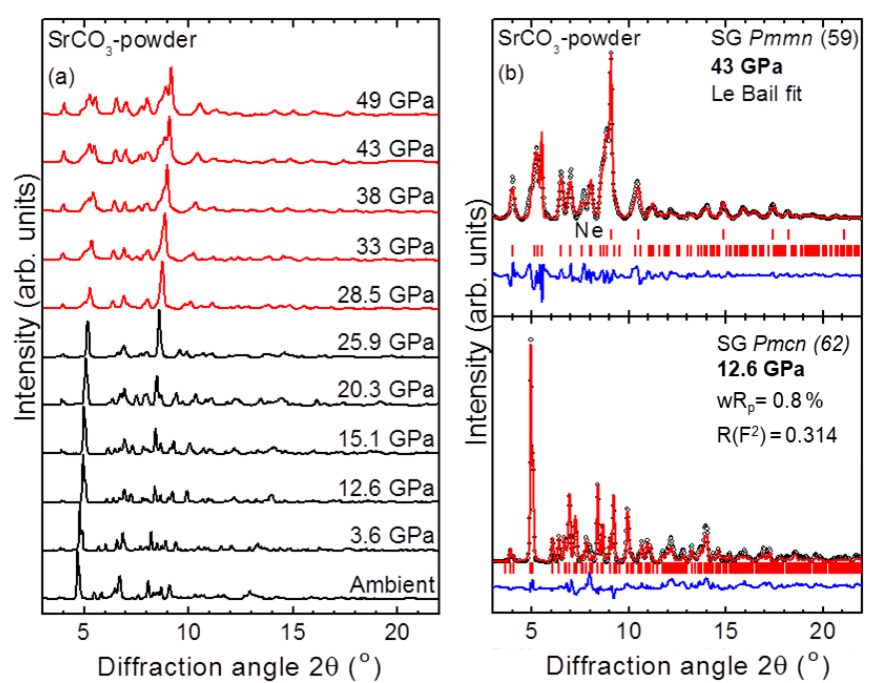
Figure 2. (a) Powder XRD patterns of SrCO 3 at various pressures ( T = 300K; λ = 0 . 2906Å). The different phases are indicated by black (SrCO 3 -I) and red (SrCO 3 -II) colours. (b) Refined XRD patterns for the aragonite-type SrCO 3 -I phase (12.6GPa, Rietveld, bottom) and for SrCO 3 -II (43GPa, Le Bail, top). Dots correspond to the measured spectra and the solid red lines represent the best refinements. The difference curves between the measured and the refined patterns are depicted as well (blue curves). Vertical ticks mark the Bragg peak positions.